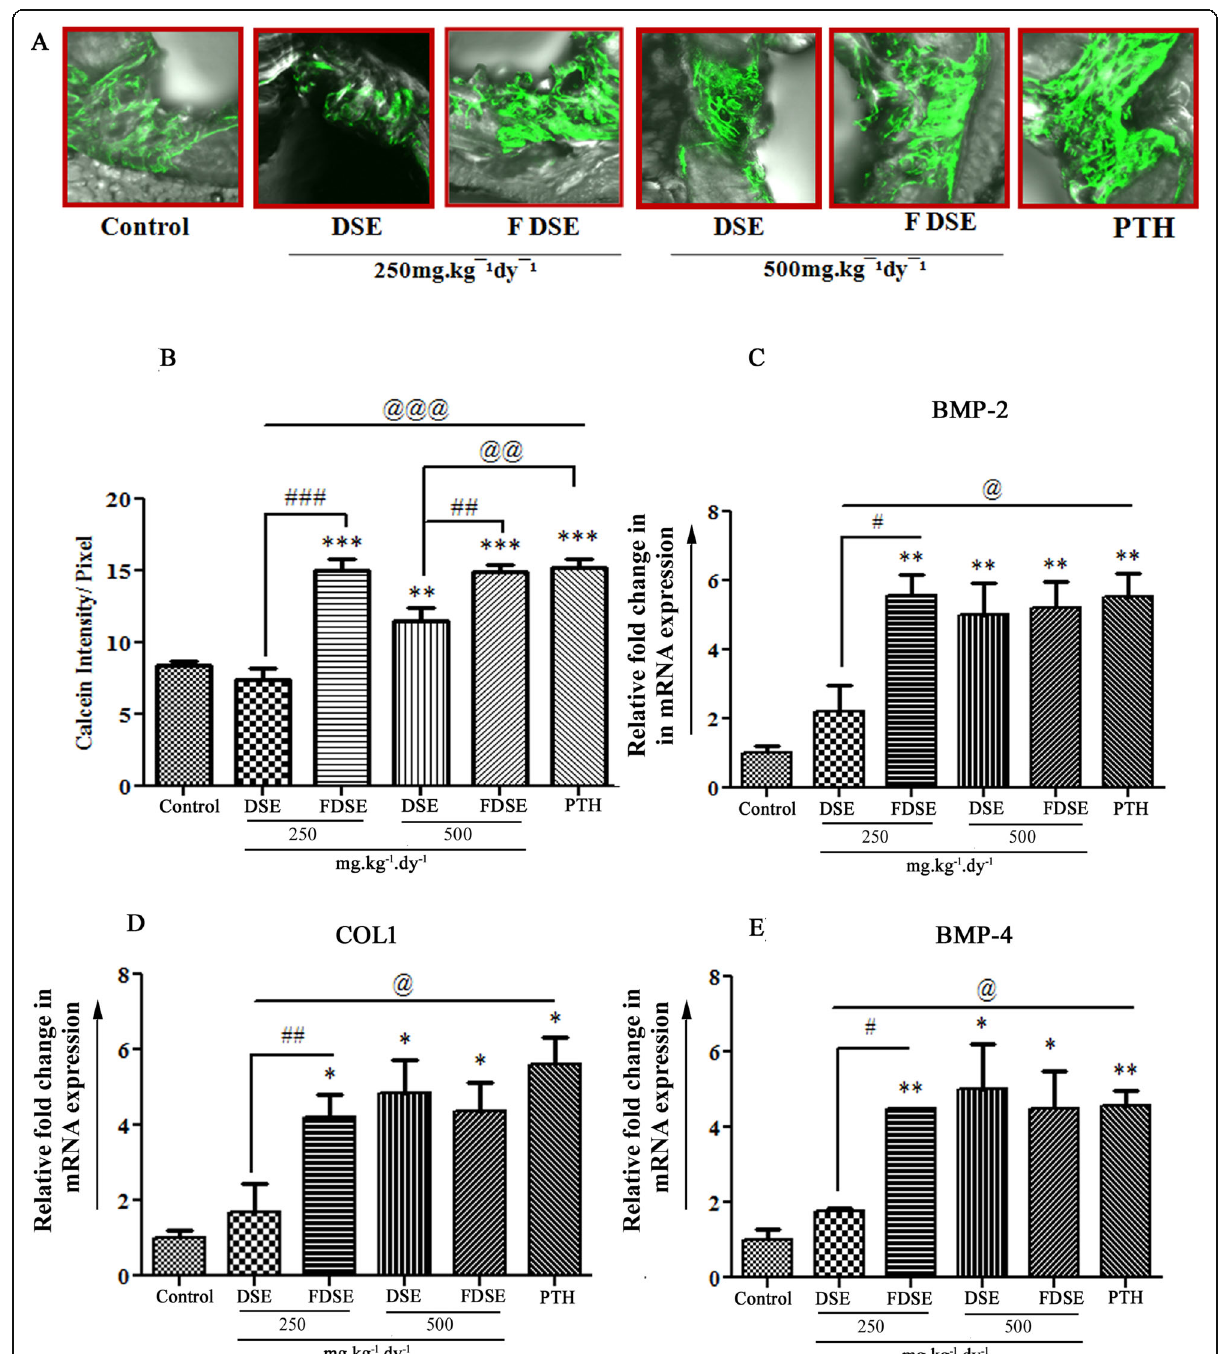
Fig. 3 a Representative confocal images (X100) of calcein labeling in the drill-hole site of various groups. b Data shows the quantification of the mean intensity of calcein labeling at the drill-hole site after treatment. Expression of osteogenic genes BMP2 ( c ), COL1 ( d ), BMP4 ( e ) quantitated by qPCR at fracture site. Values represent Mean ± SEM (n = 10 rats/group). * p < 0.05, ** p < 0.01, *** p < 0.001 compared with control. # p < 0.05, ## p < 0.01, ### p < 0.001 compared to formulated extract (FDSE) with corresponding dose of extract (DSE). @ p < 0.05, @@ p < 0.01, @@@ p < 0.001 compared to